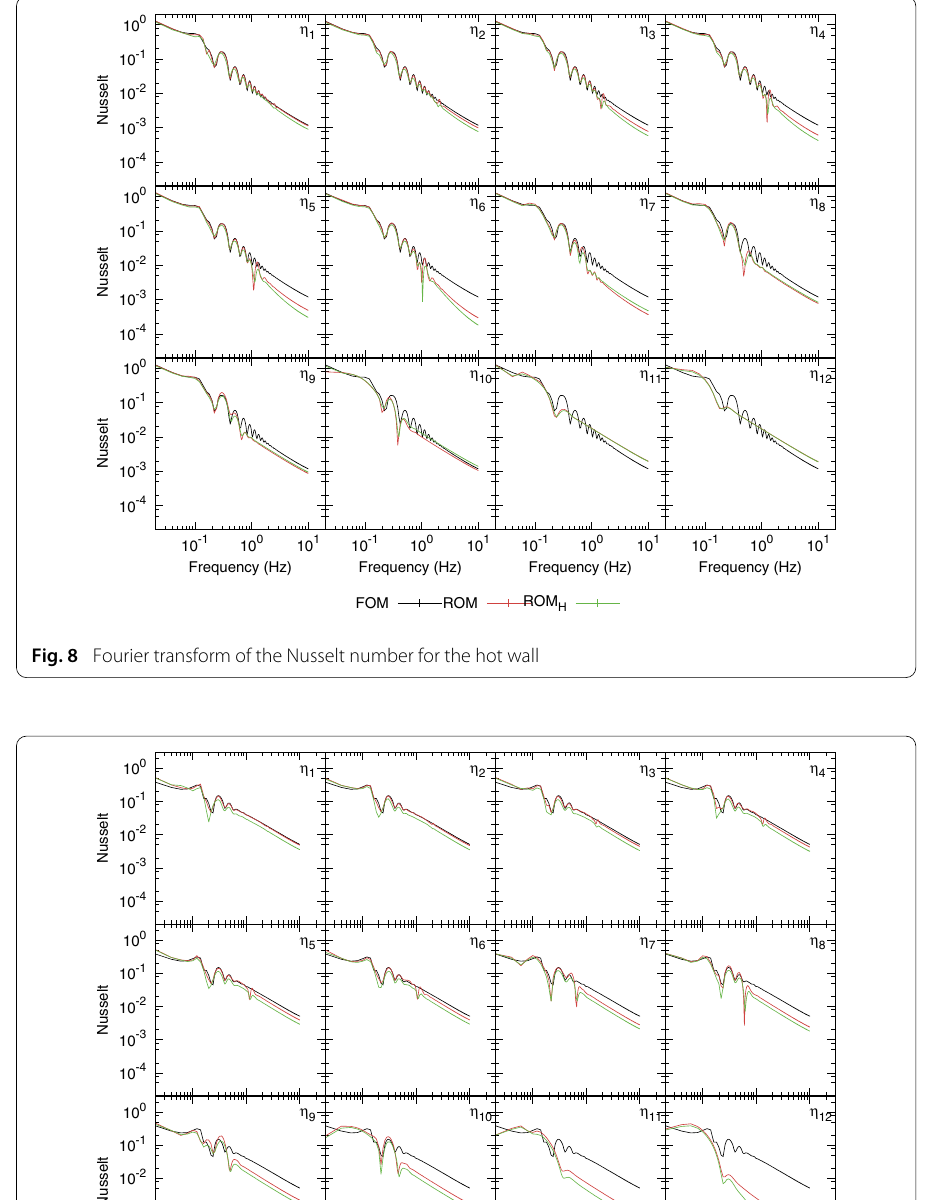
FOM and the ROM; and one with 35937 elements and a mesh size h = 0 . ¯ 03, for solving the hyper-ROM. To construct the basis, we collect 500 snapshots for velocity, pressure and temperature at every 2 time steps in a 10 s